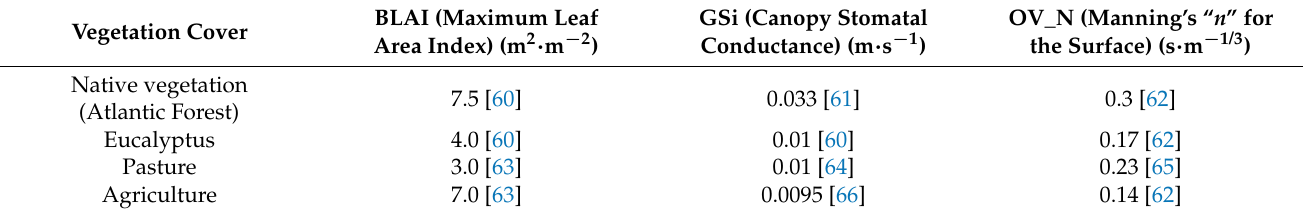
Table 2. Modified vegetation parameters as Maximum leaf area index (BLAI), Canopy stomatal conductance (GSi) and Manning’s “ n ” for the surface (OV_N) from the SWAT model’s database. BLAI (Maximum Leaf GSi (Canopy Stomatal OV_N (Manning’s “ n ” for Vegetation Cover Area Index) (m 2 · m − 2 ) Conductance) (m · s − 1 ) the Surface) (s · m − 1/3 ) Native vegetation (Atlantic Forest) Eucalyptus